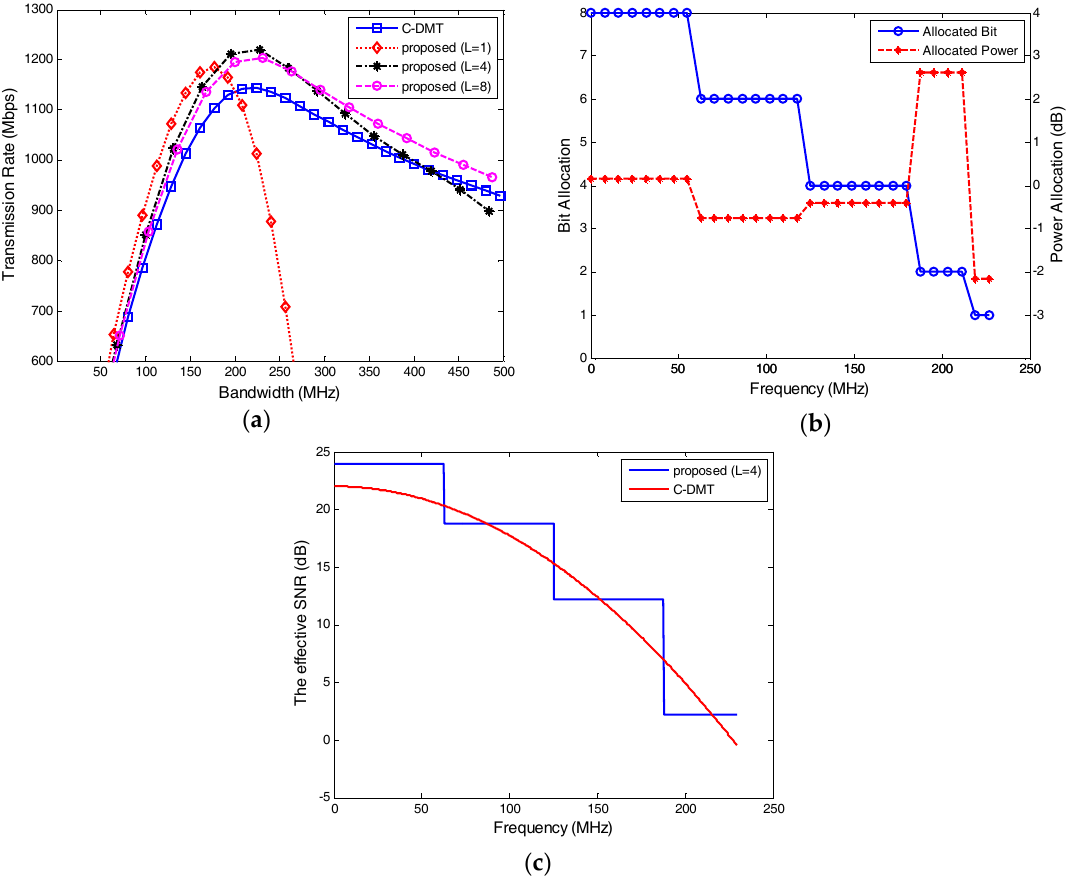
Figure 9. Fifty-metre step index polymer optical fiber (SI-POF) transmission ( a ) Transmission rate (at a bit error rate (BER) of 10 − 3 , without channel coding) ( b ) Bit and power distribution of the proposed scheme with L = 4 (for transmission rate of 1.204 Gbps) ( c ) The effective SNRs distribution.